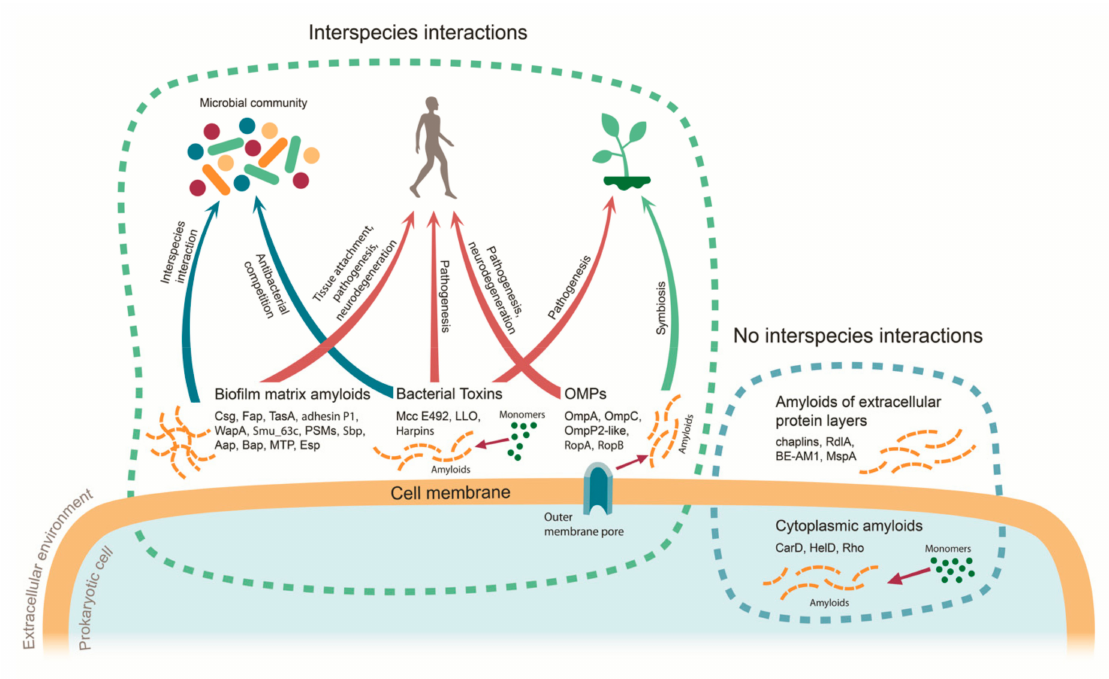
Figure 1. Functions of prokaryotic amyloids in the interspecies interactions. Dots denote monomeric proteins, striated lines denote amyloid fibrils, and monomer-to-amyloid conversion is shown as a thin arrow. Thick arrows represent di ff erent types of interspecies interactions: red for Type I (host–pathogen), blue for Type II (interactions within microbial community), and green for Type III (host–symbiont). MTP— Mycobacterium tuberculosis pili; LLO—listeriolysin O; OMPs—outer membrane proteins; PSMs—phenol-soluble